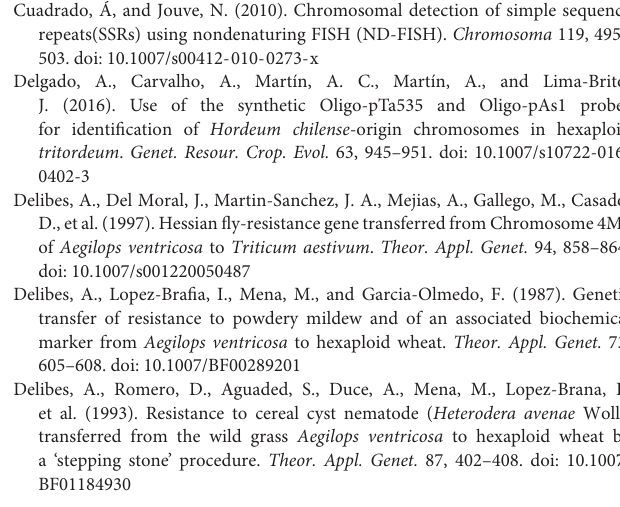
FIGURE S1 | FISH analysis for metaphase spreads with chromosomal numerical variations. (A–L) Metaphase spreads with 46, 47, 48, 49, 50, 51, 52, 53, 54, 55, 56, and 57 chromosomes, respectively. 1s: Metaphase spread investigated using Oligo-pSc119.2 (green) and Oligo-pTa535 (red) as probes, 2s: Metaphase spreads using Oligo- (GAA) 7 (yellow) as probe. Chromosomes were stained with DAPI (blue on 1s and red on 2s). Green denotes chromosome loss and yellow denotes showed chromosome gain. The two chromosomes lost are listed at the lower right corner of every images. FIGURE S2 | FISH analysis for metaphase spreads with chromosomal structural variations. (A–T) Metaphase spreads with 1AS. 1AL-, 3AL, -4AS.4AL, 7BS. 7BL-, 6AL, 1BL, 2BS. 2BL-, 4BL, 5BS, -6BS.6BL, 2D v L, 3D v L, 6D v S.6D v L-, 1N v L, 3N v S.3N v L-, 6N v S, 3BL.3BL, 5N v L.5N v L, 7A.7D v , 5AL.5AL, and 7N v L.3BL, respectively. 1s: Metaphase spread investigated using Oligo-pSc119.2 (green) and Oligo-pTa535 (red). 2s: Metaphase spreads investigated using Oligo- (GAA) 7 (yellow). Chromosomes were stained with DAPI (blue on 1s and red on 2s). Red denotes type of chromosomal structural